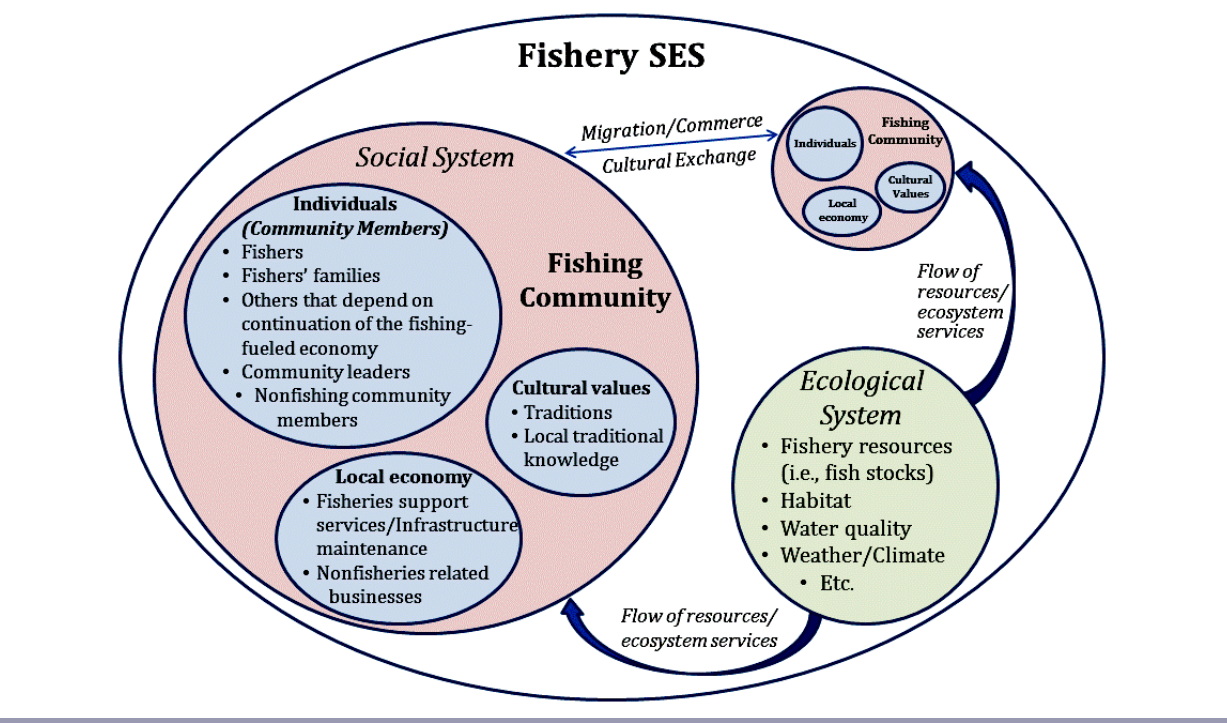
Fig. 1 . Nested systems within a fishery social-ecological